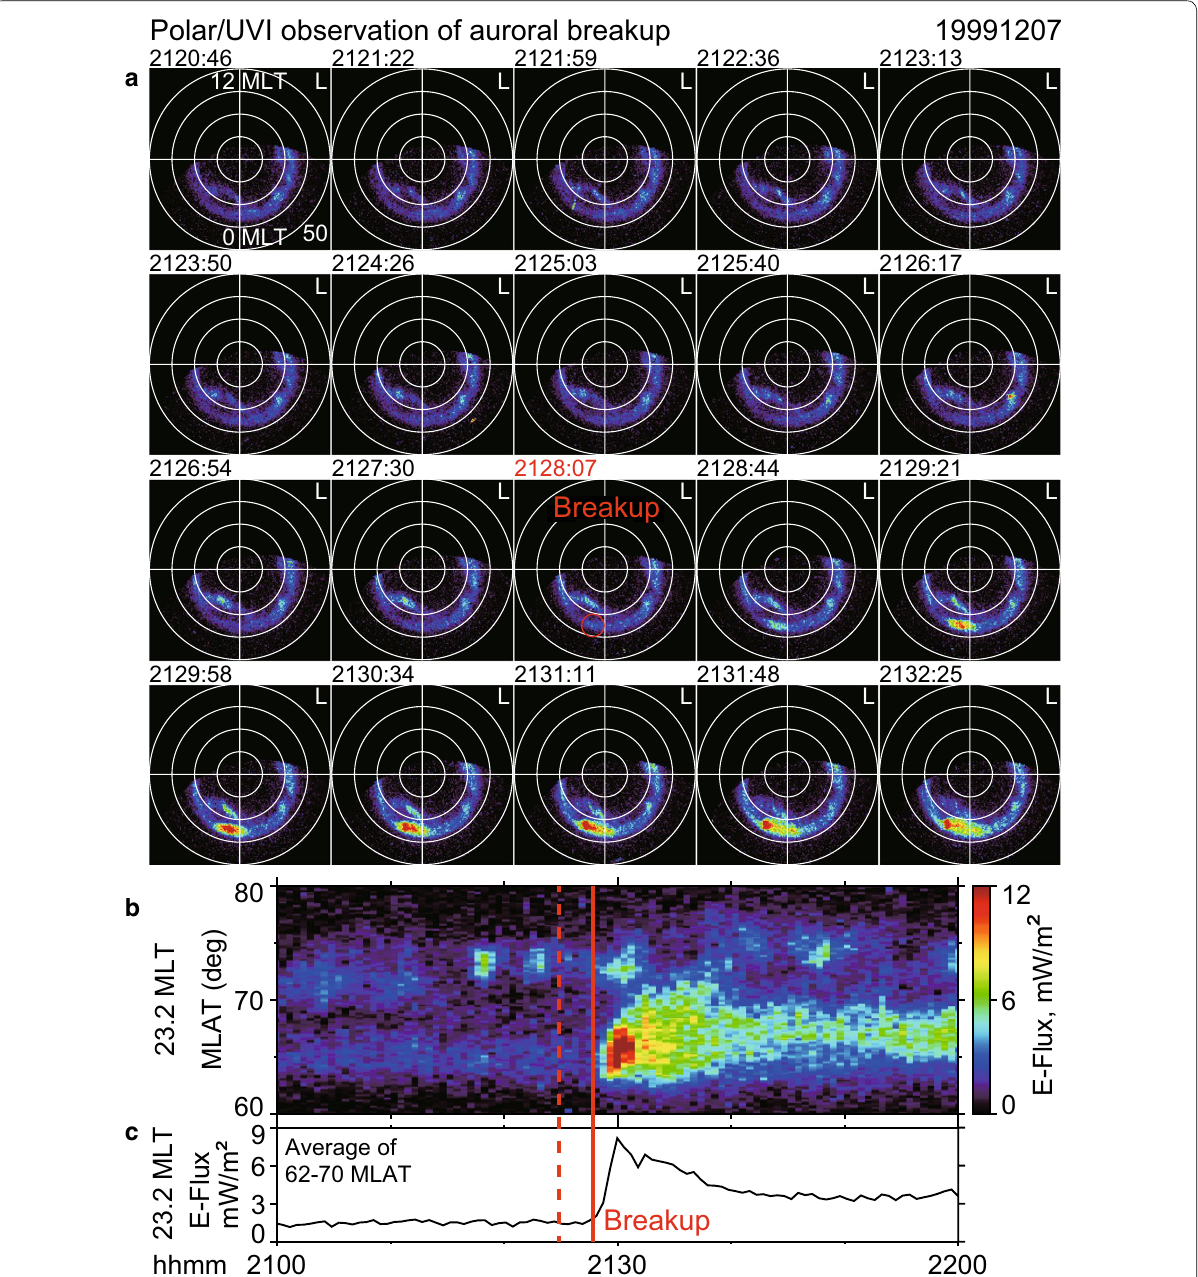
Fig. 3 Polar satellite ultraviolet observations of an auroral breakup on December 7, 1999. Auroral brightness at a wavelength of 170 nm (LBHL) is shown after projection in the modified APEX magnetic coordinates at an altitude of 110 km in the polar ionosphere. The auroral brightness is converted to the corresponding energy flux of precipitating electrons that cause auroras. a Time series of full-time (36.8-s) resolution images shown in false color from left to right. The time labels of images were chosen as the center of the image accumulation period (36.8 s for the present case). An auroral breakup (red circle, 23.2 MLT, 64.6 ◦ MLAT) is first seen in the panel labeled 2128:07 UT in red. Because the previous image was taken at 2127:30 UT, we estimate that the breakup began at 2127:49 UT (i.e., the center time of the two images). b Auroral keogram sliced along the onset meridian (23.2 MLT, 0.2 h average). c Auroral brightness averaged over 23.0–23.4 MLT and 62–70 MLAT. The solid red line in b and c indicates the ± breakup at 2127:49 UT. The dashed red line indicates 2124:50